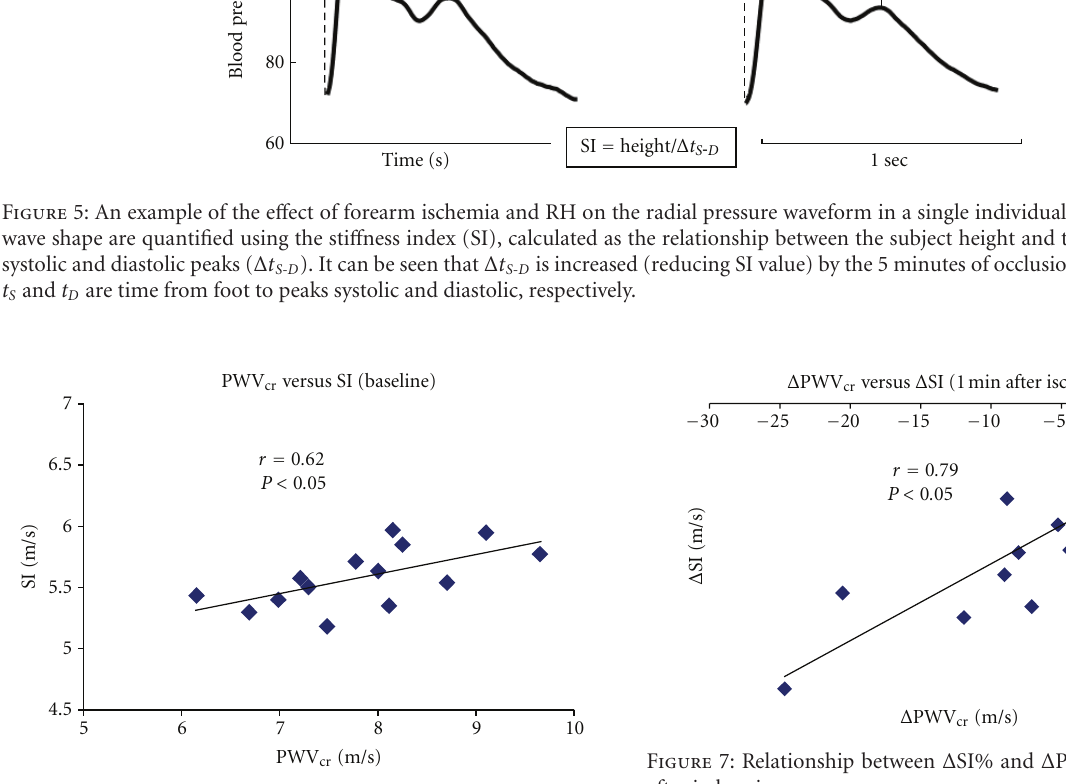
Figure 6: Simple regression analysis comparing SI and PWV cr in basal conditions.